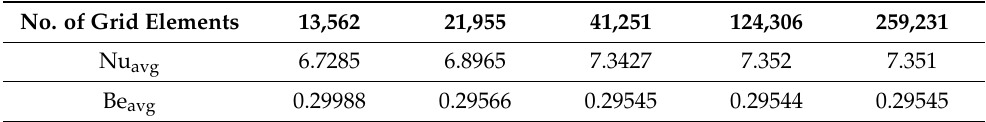
Table 3. Different mesh sizes for Ha = 0, Ω =0, and ϕ = 0.02. No. of Grid